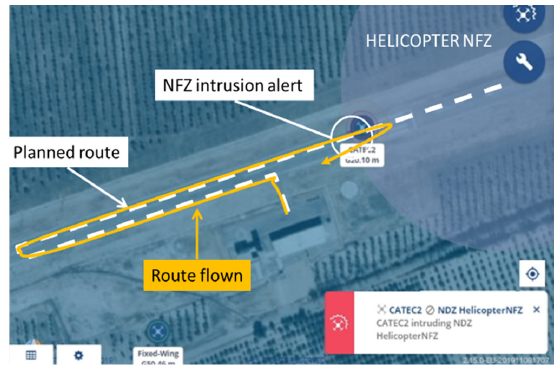
Figure 4. NFZ activation scenario with the key elements highlighted.